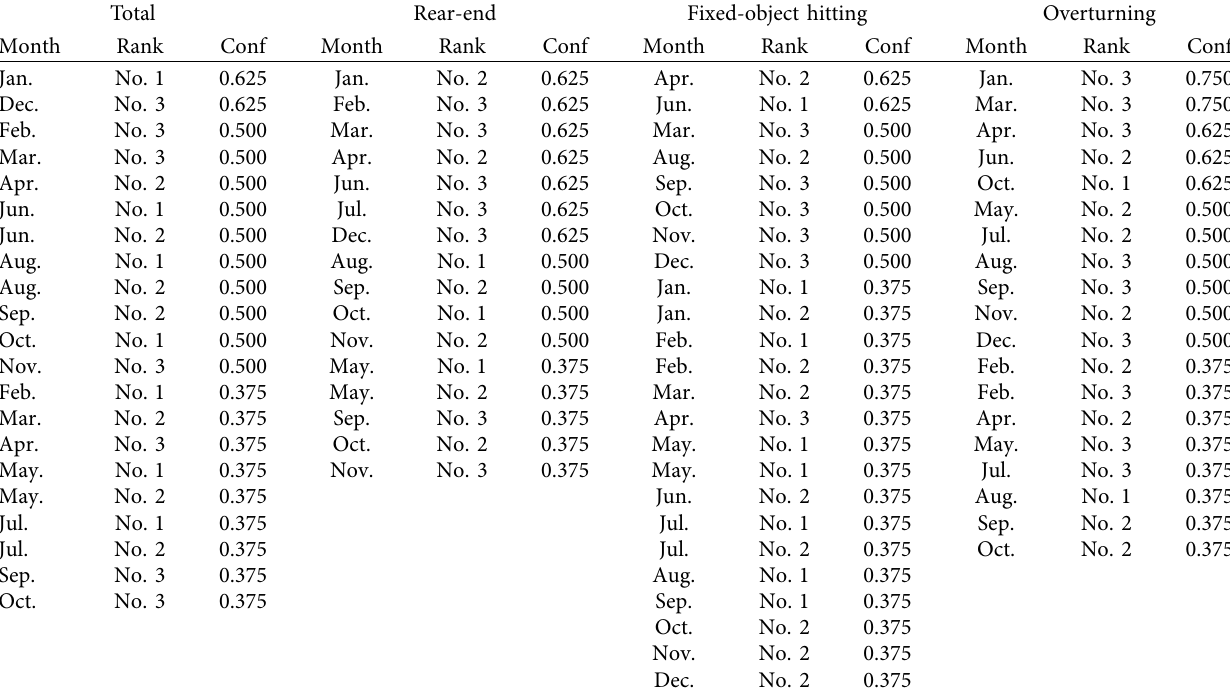
Table 2: The confidence distribution of Apriori